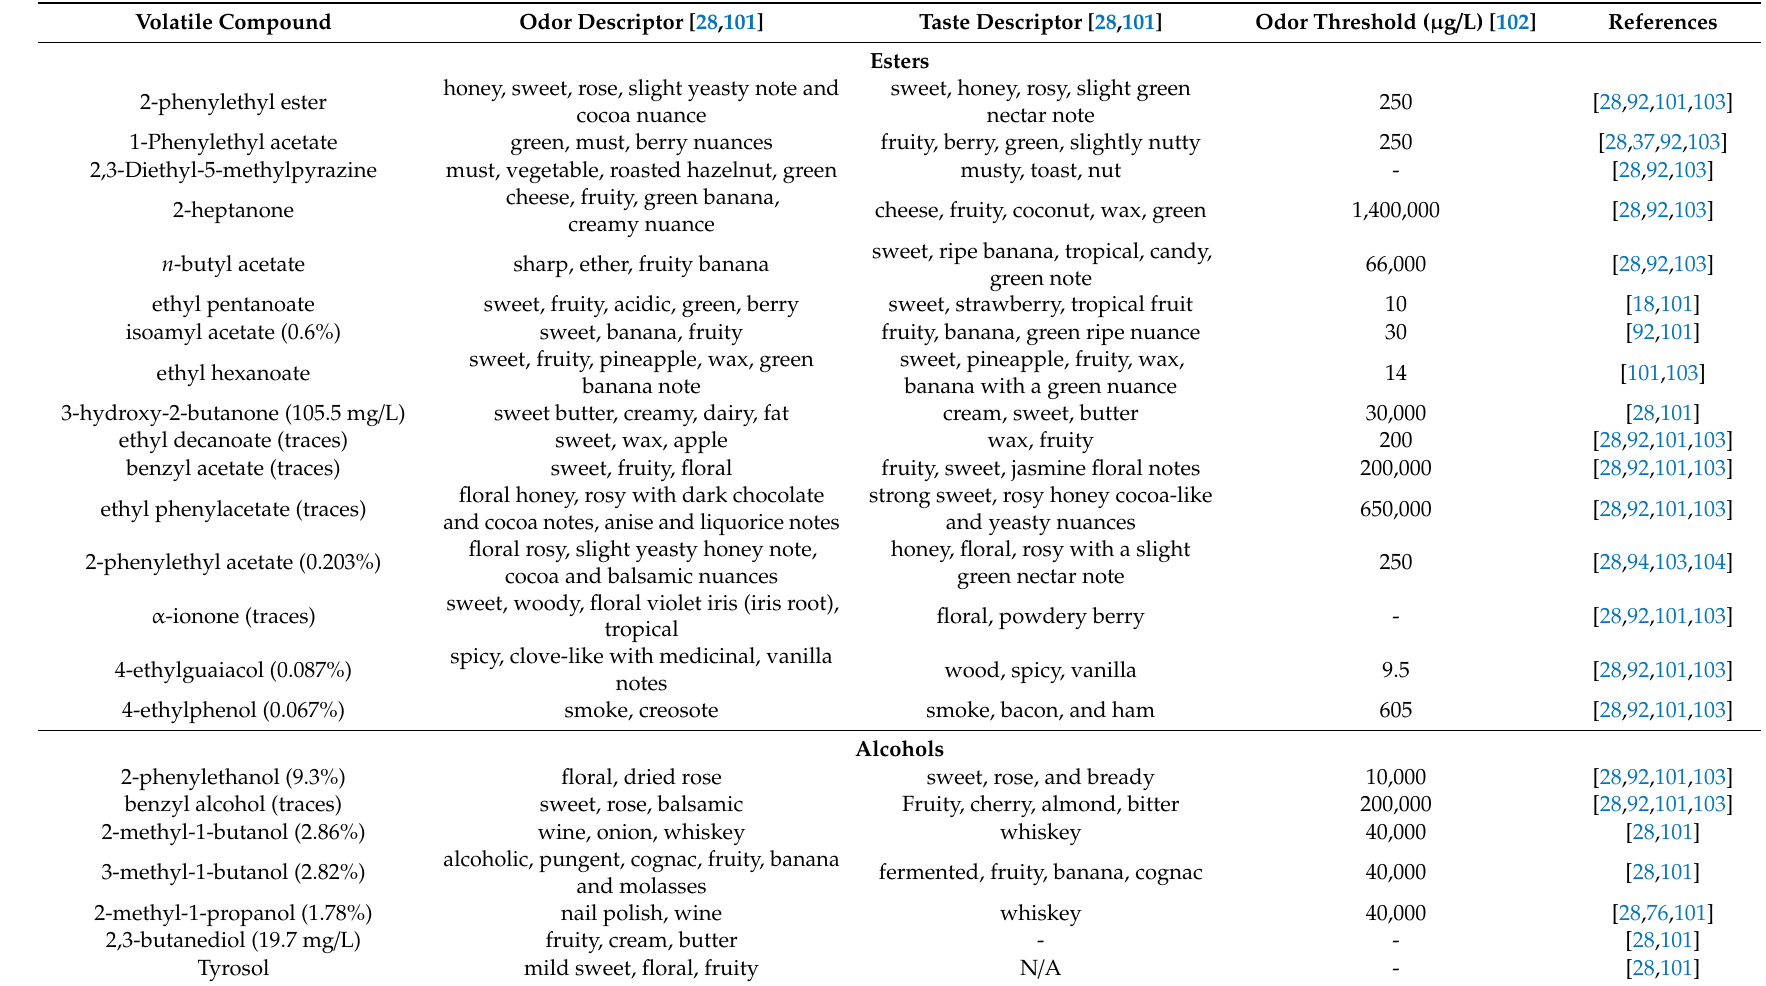
Table 4. Volatile organic compounds found in honey